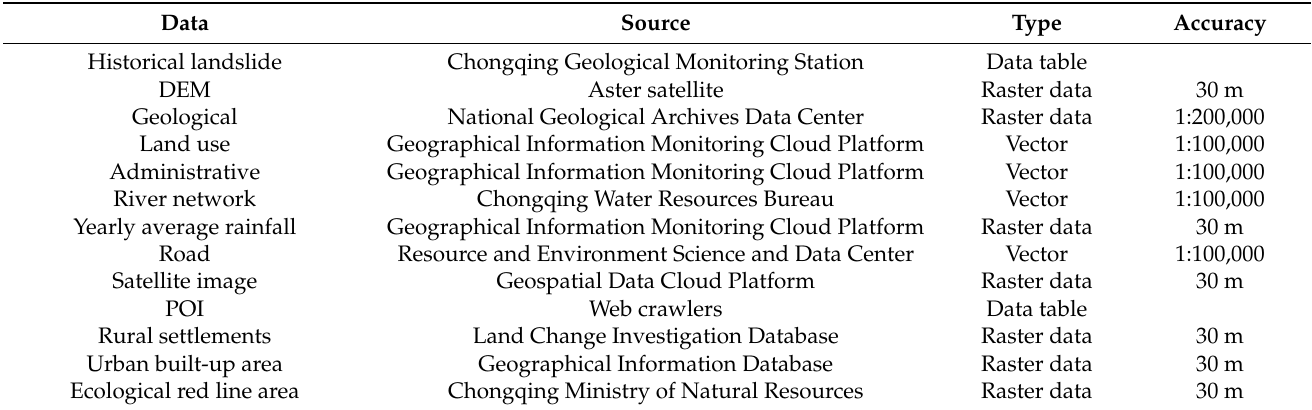
Table 1. Data and data sources for landslide susceptibility